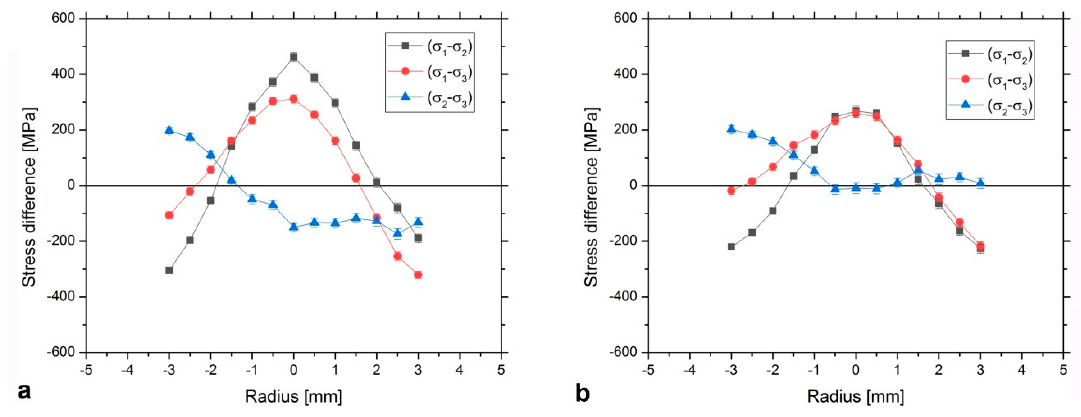
Figure 4. Stress di ff erences for swaged sample bars: W_A ( a ); W_B ( b Figure 4. Stress differences for swaged sample bars: W_A ( a ); W_B ( b ).